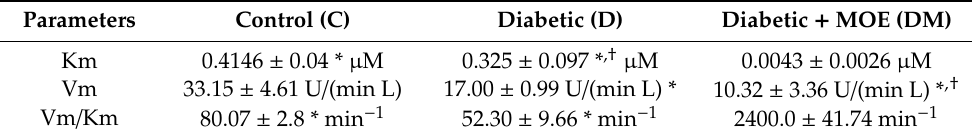
Figure 1. Calculation of Km and Vm from substrate concentration versus time plots. The image shows a representative trace of five repetitions for each rat of a different group. Table 1. Kinetic parameters of rPON1 obtained from Lambert W function.